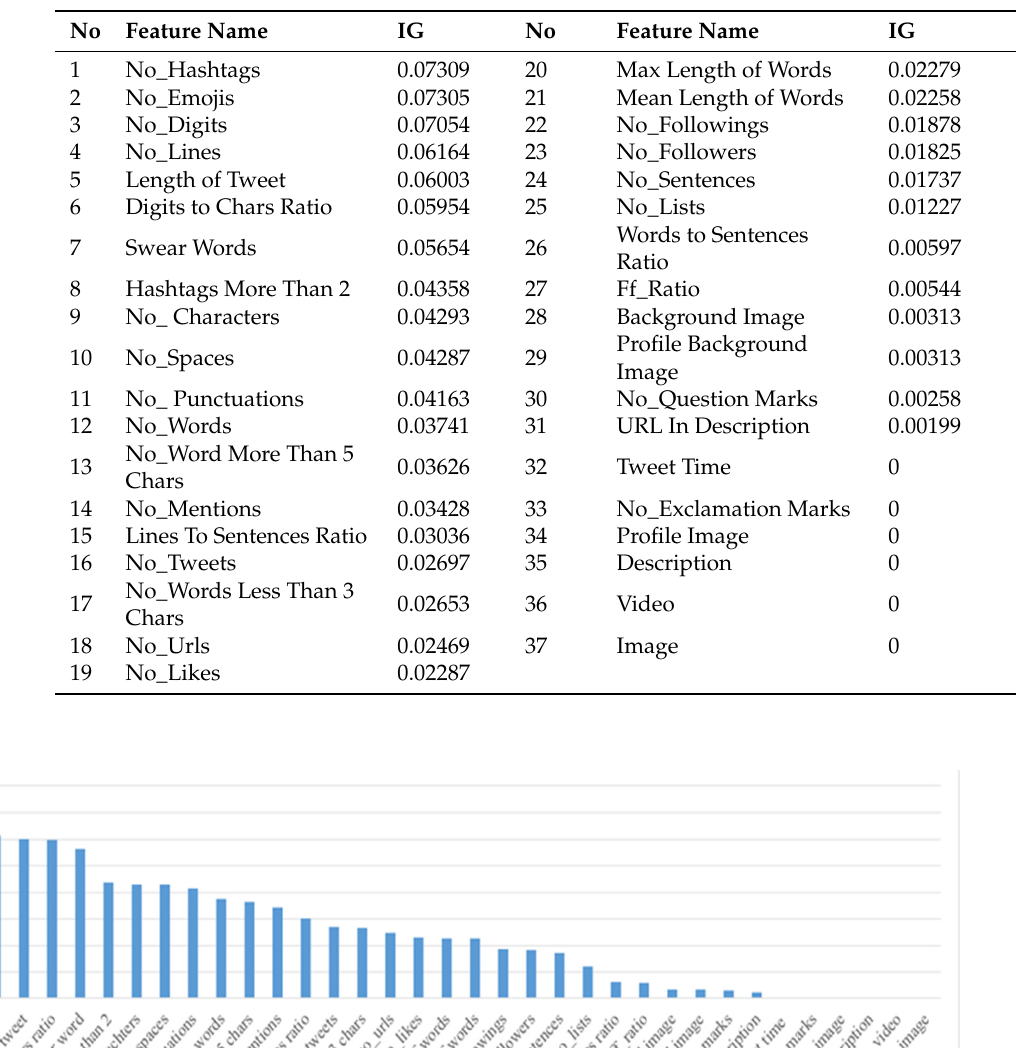
Table 4. Information gain of each feature.